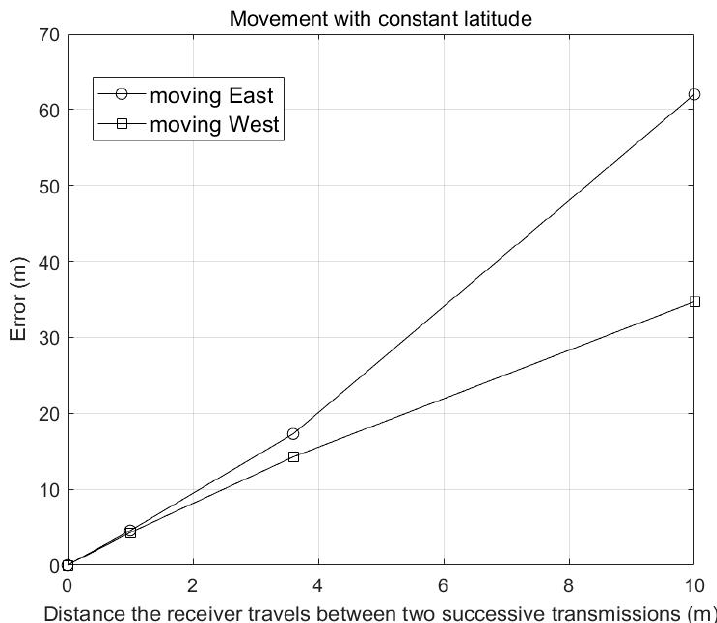
Figure 3. Error when the receiver is moving along a parallel.